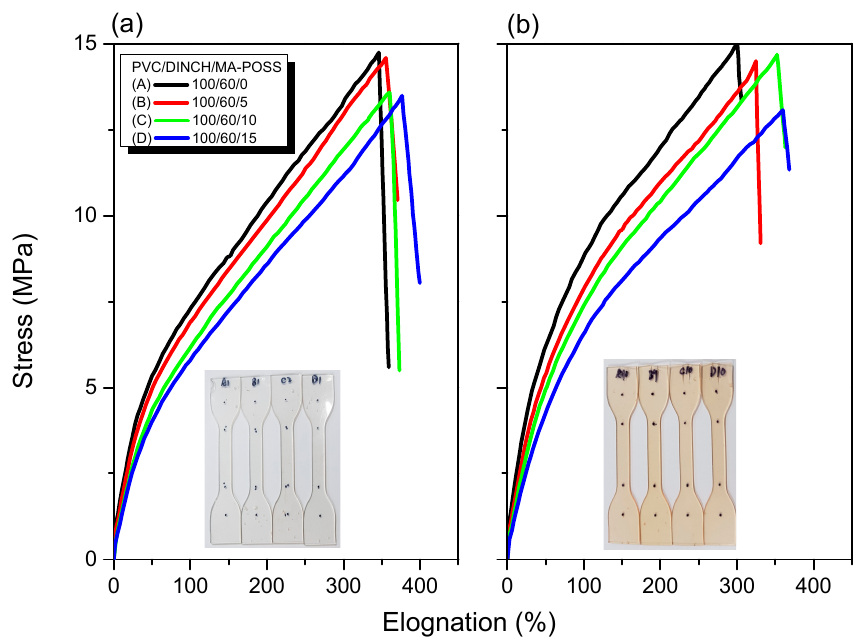
Figure 8. Stress–strain curves of PVC/DINCH/MA-POSS blends at various MA-POSS contents ( a ) before and ( b ) after thermal annealing at 100 °C for 7 days. The inset displays the tensile test samples used in this study ( a ) before and ( b ) after thermal annealing.